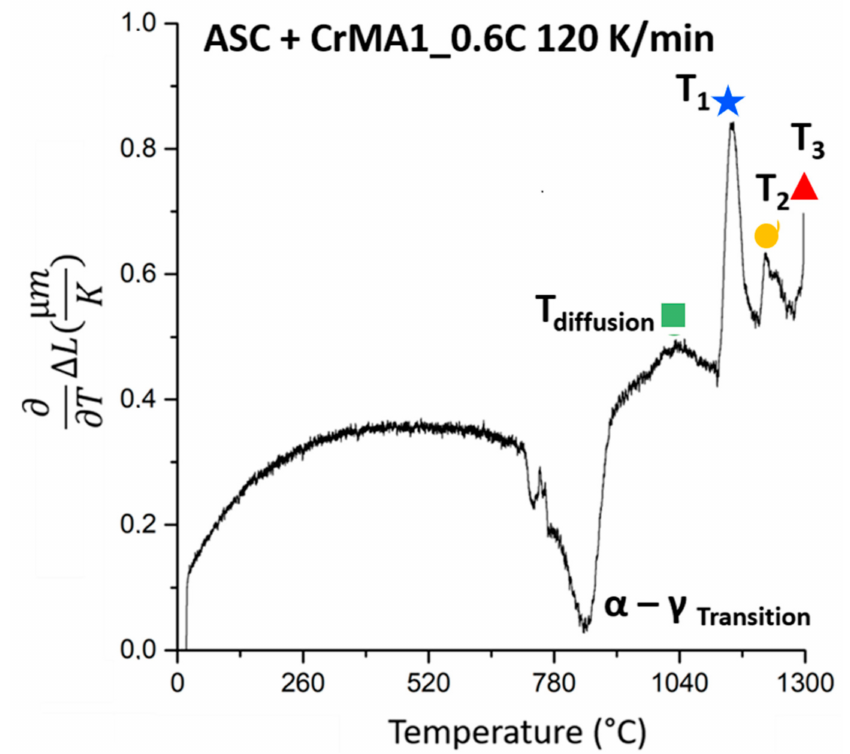
Figure 5. ASC + CrMA1_0.6C (0.6C): 1st deviation of the heating segment measured with 120 K/s. Example how T 1 , T 2 , and T 3 were chosen.